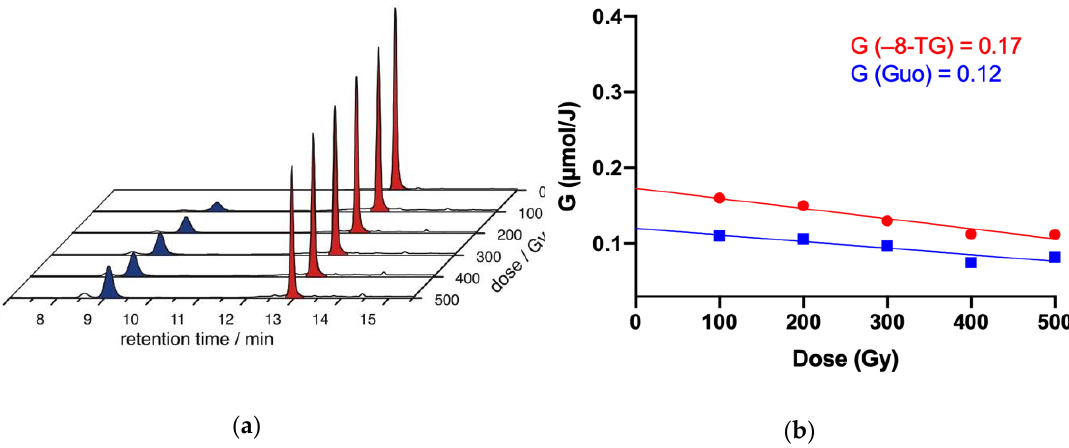
Figure 7. γ -radiolysis of 1 (0.196 mM) in N 2 -purged water at a natural pH at a dose rate of 1.85 Gy · min − 1 . ( a ) HPLC runs of the reactions. The HPLC peaks of 1 are highlighted in red, while the peaks of guanosine ( 2 ) are highlighted in blue. ( b ) The chemical irradiation yields G ( − 1 ) ( (cid:8) ) and G ( 2 ) ( (cid:4) ) as a function of the irradiation dose. The line extrapolated to the zero dose leads to the G values reported in the graph.